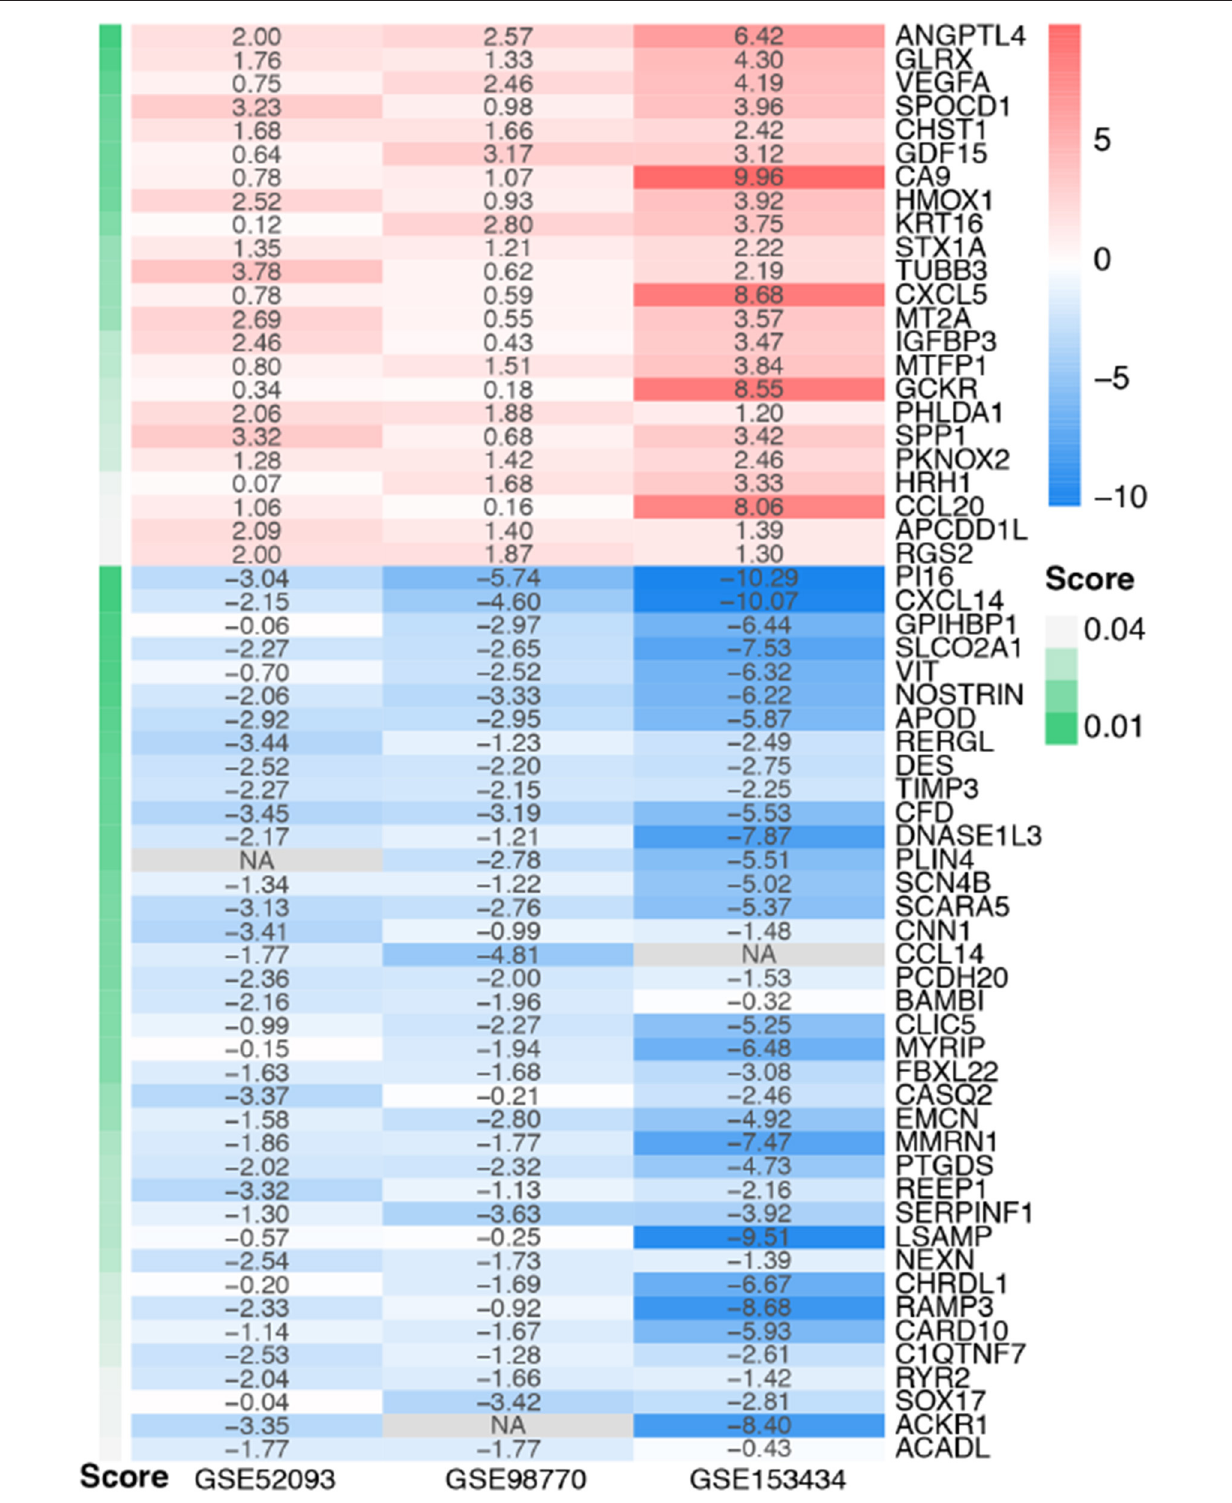
Frontiers in Cardiovascular Medicine |